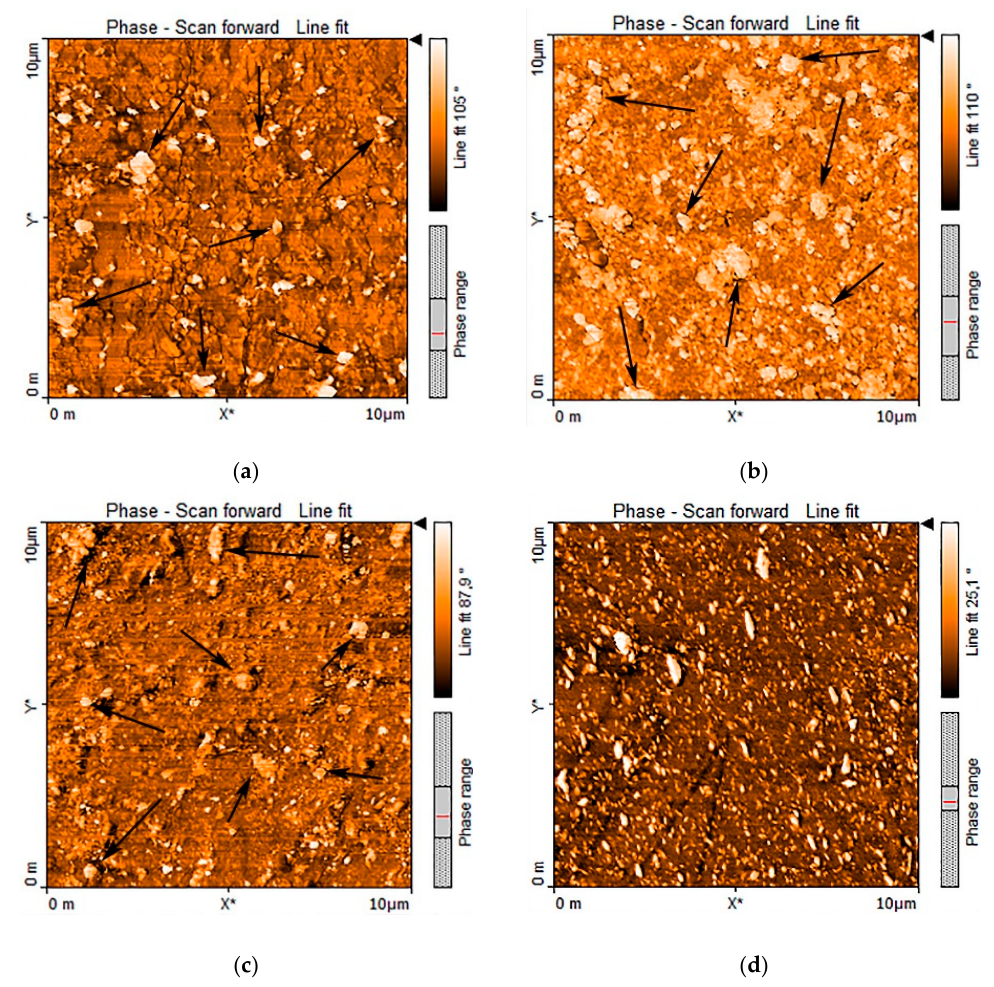
Figure 12. Atomic force microscopy (AFM) phase images (10 µ m × 10 µ m) of ( a ) TPU125 / NBR, ( b ) TPU125 / XNBR, ( c ) TPU125 / ENR, and ( d ) TPU125.